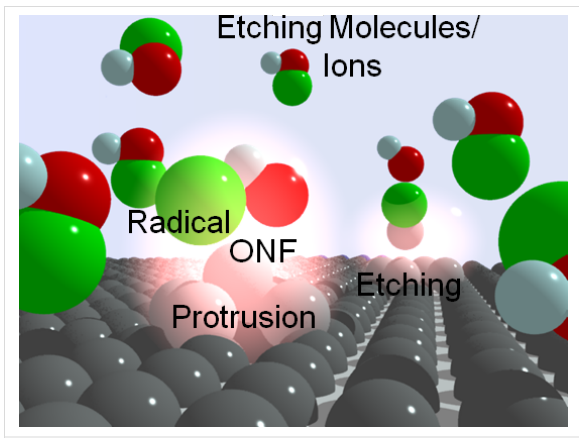
Figure 1: Schematic of the near-field etching process.